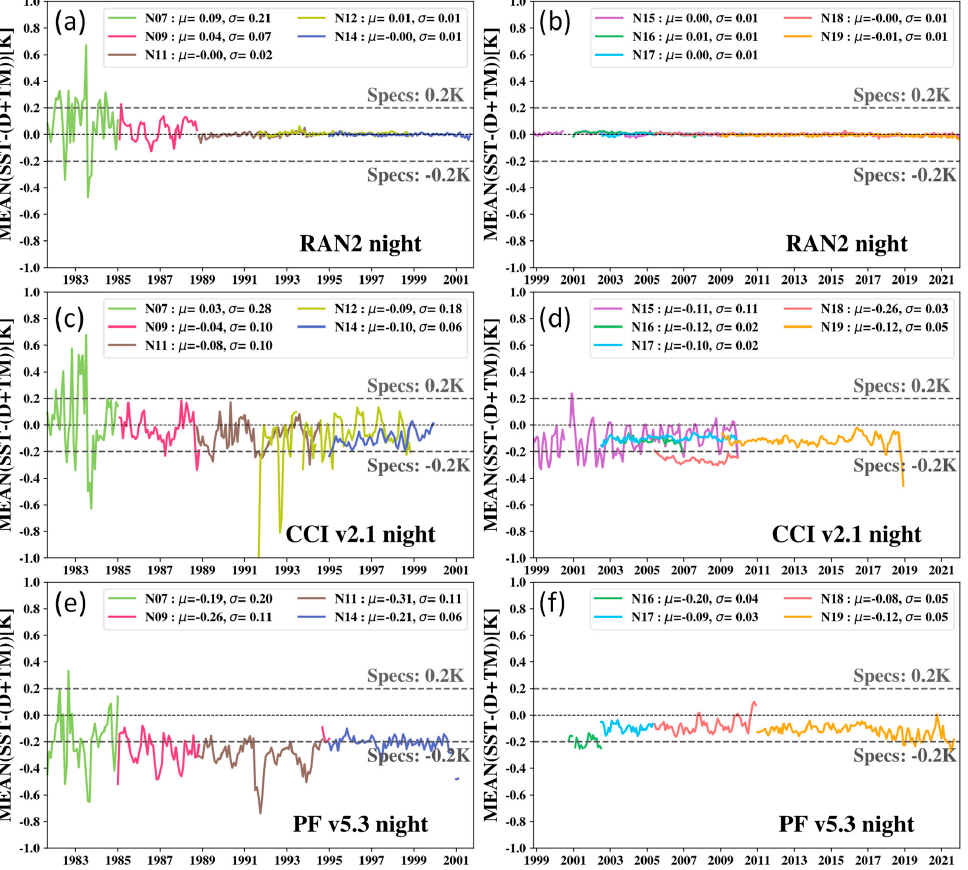
Figure 14. Global monthly nighttime biases with respect to (D + TM) for ( a , b ) RAN2 ‘subskin’ SST, ( c , d ) CCI ‘skin’ + 0.17 K and ( e , f ) PF ‘skin’ SSTs + 0.17 K. ( a , c , e ) AVHRR/2s; ( b , d , f ) AVHRR/3s. (Data are from the NOAA SQUAM system [21,22].) In CCI, the SDs are larger and more variable than in RAN2. The mission-averaged values reduce from N07 to N11 and vary between 0.40 K and 0.46 K for all subsequent satellites. In PF, the SDs are larger and more variable than in RAN2, for all satellites. The same observation holds for N11–N19 in CCI. For the most stable satellites N14–N18, the mission-averaged PF SDs vary from 0.55–0.60 K (cf. corresponding SDs ~0.35–0.39 K in RAN2 and ~0.42–0.46 K in CCI). The mission averaged SDs for N19 in PF (0.47 K) are the smallest, out of all satellites, but still larger than in RAN2 (0.39 K) and CCI (0.44 K).